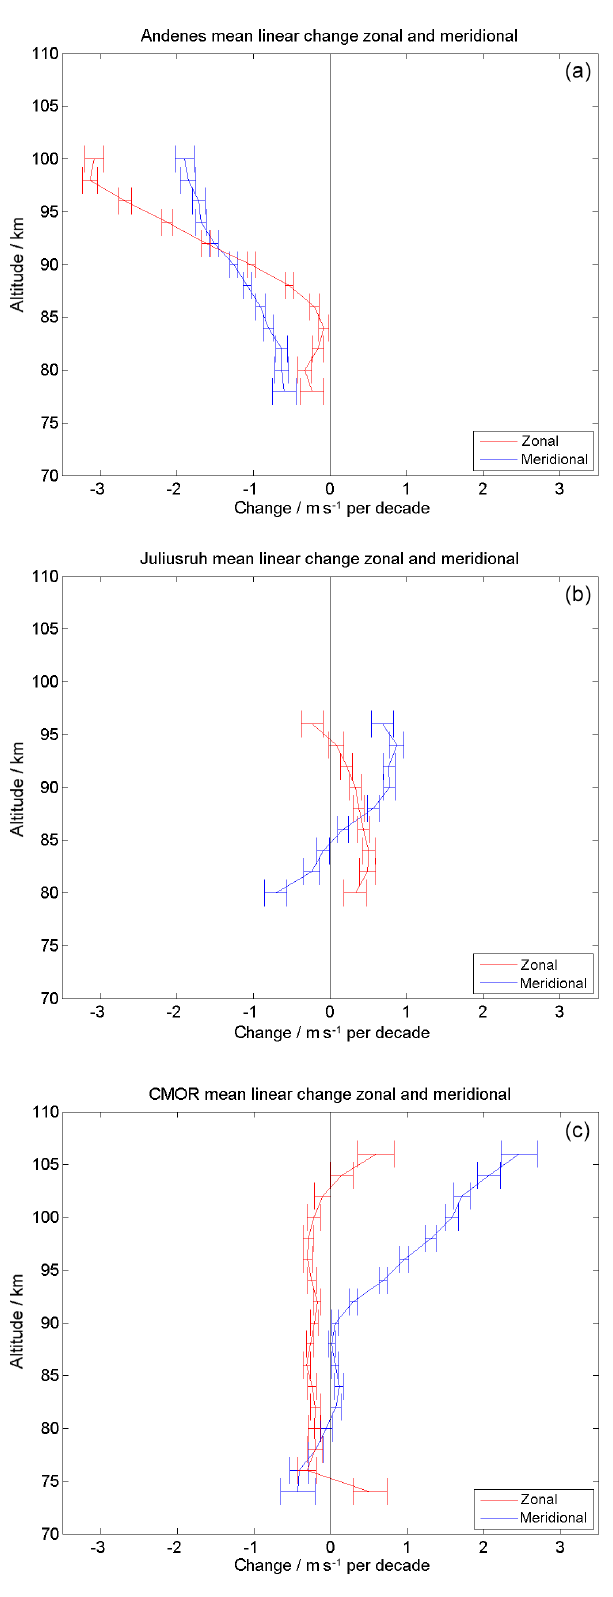
Figure 6. Linear long-term changes in zonal (red) and meridional (blue) wind, based on annual values for Andenes (a) , Juliusruh (b) , and CMOR (c) . The error bars correspond to the statistical